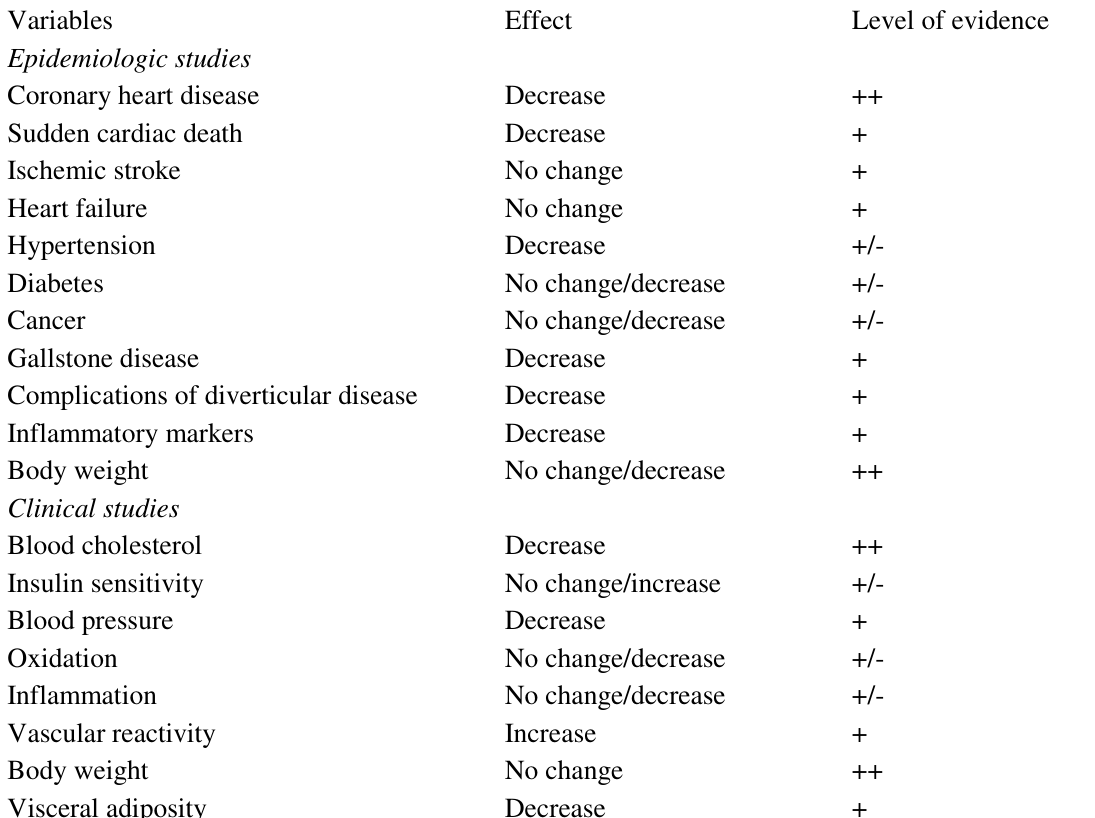
Table 3 . The effect of nut consumption on cardiovascular risk factors. Summary of scientific